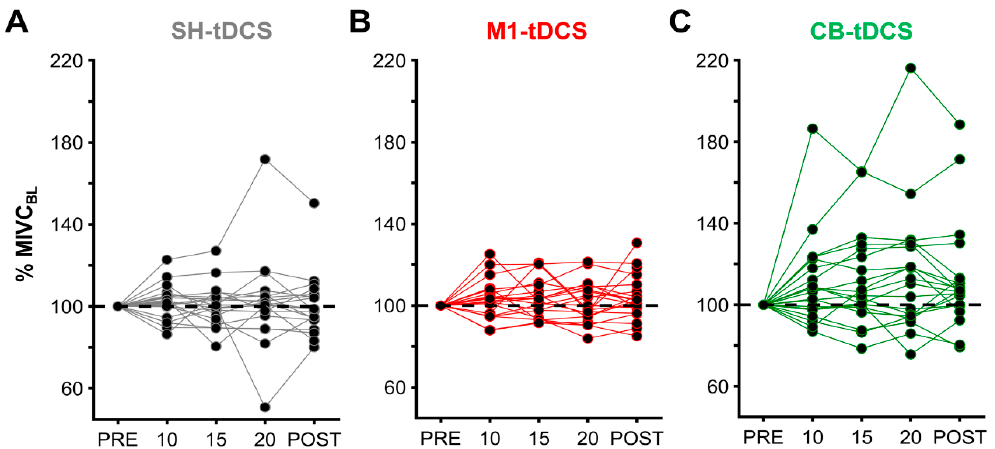
Figure 4. MIVC results I. Individual MIVC results illustrated as percentage-wise increase respective to baseline MIVC values (% MIVC BL ), per sham (SH)-TDCS ( A ), M1-tDCS ( B ), and CB-tDCS ( C ) for all participants.